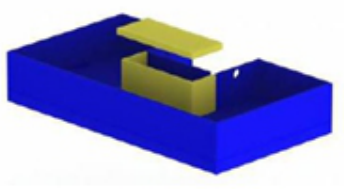
Figure 14. Electronic